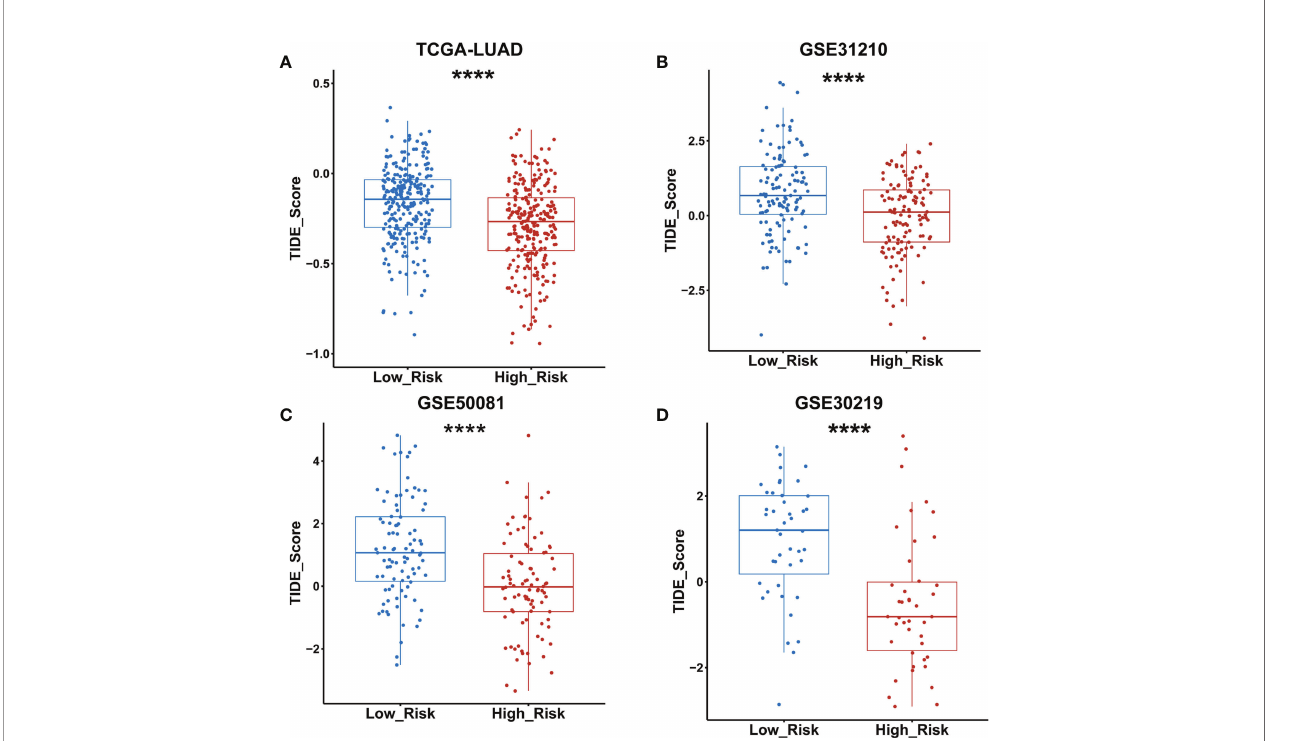
FIGURE 8 | TIDE score was signi fi cantly lower in the high- as compared to the low-risk group classi fi ed by the GDPLichi model. (A – D) Statistical analysis of TIDE scores between low and high-risk groups divided by GDPLichi model in the TCGA LUAD cohort and the three other external validation GEO datasets. ****P <